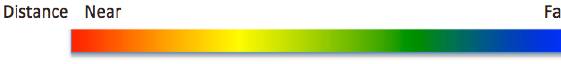
Figure 4. High collision risk area colour based on a rainbow colour map. The collision area colour is white, and it never overlaps with the rainbow colours.